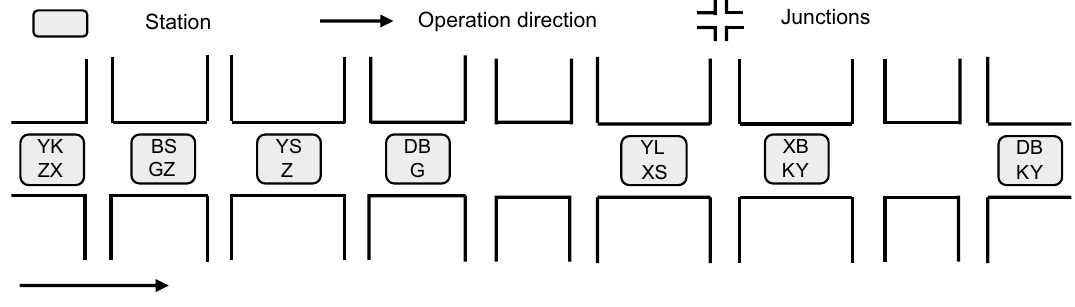
Figure 6. Schematic diagram of the line.